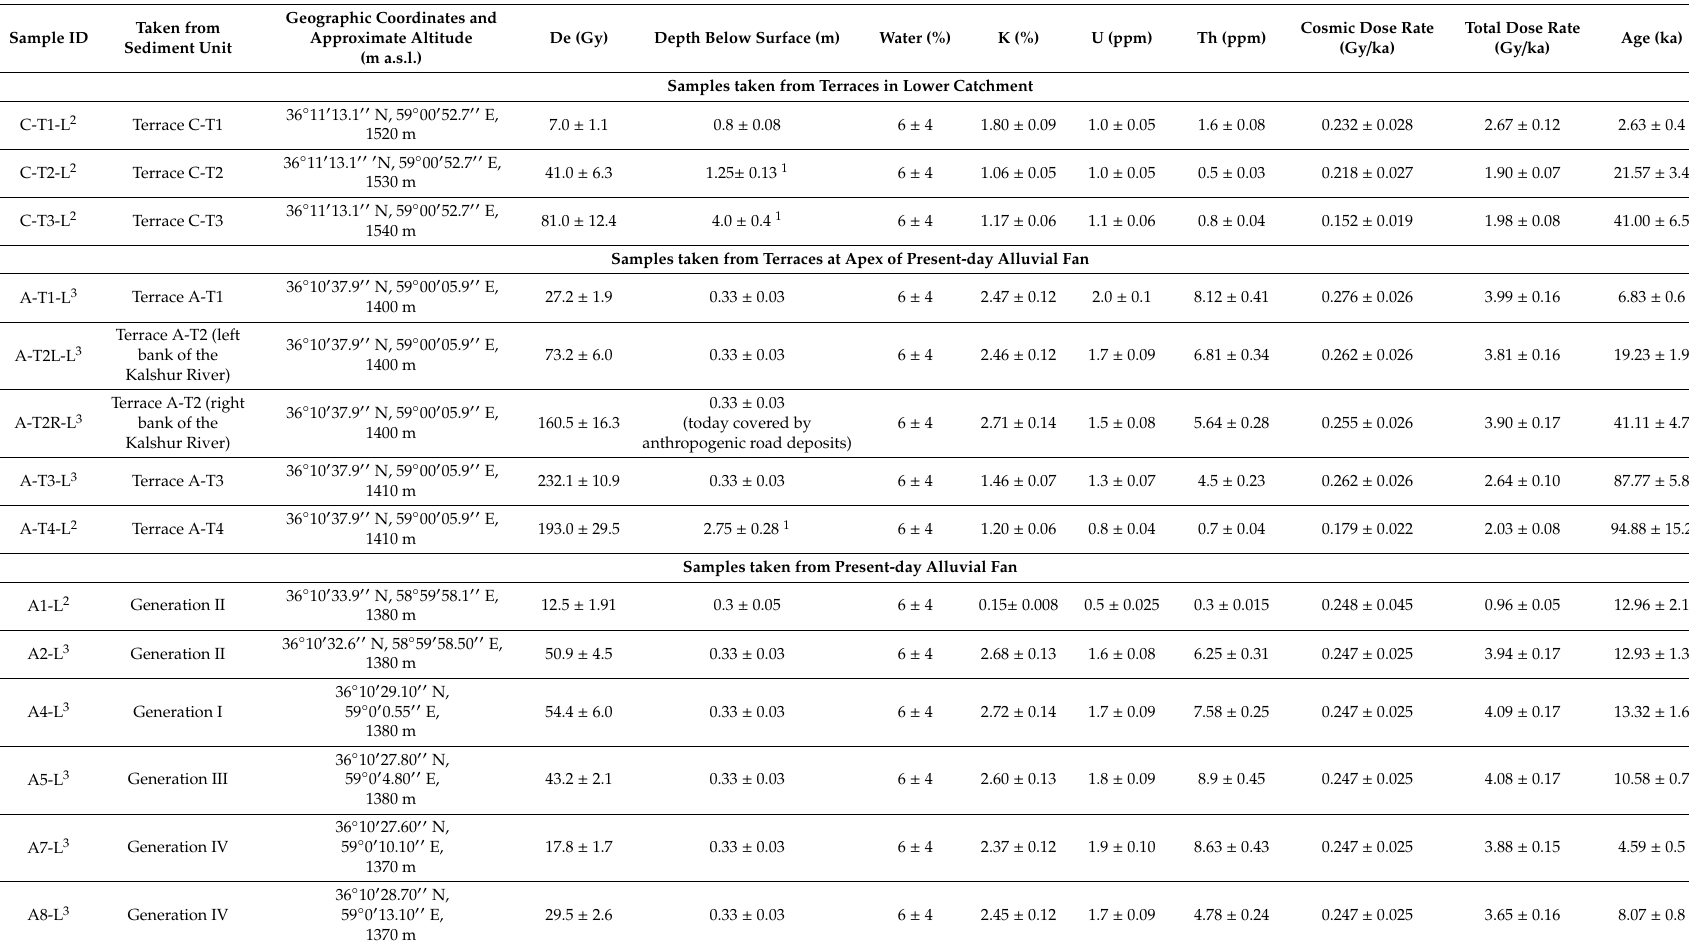
Table 1. Parameters and results of the luminescence datings (feldspar infrared stimulated luminescence (IRSL) at 50 ◦